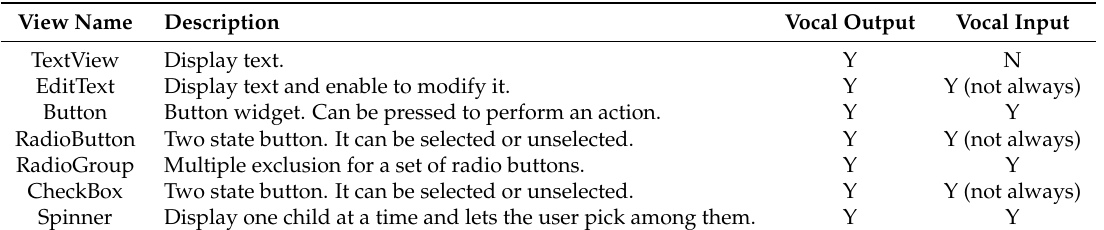
Table 2. Android views handled by the MicroApp vocal use interface.